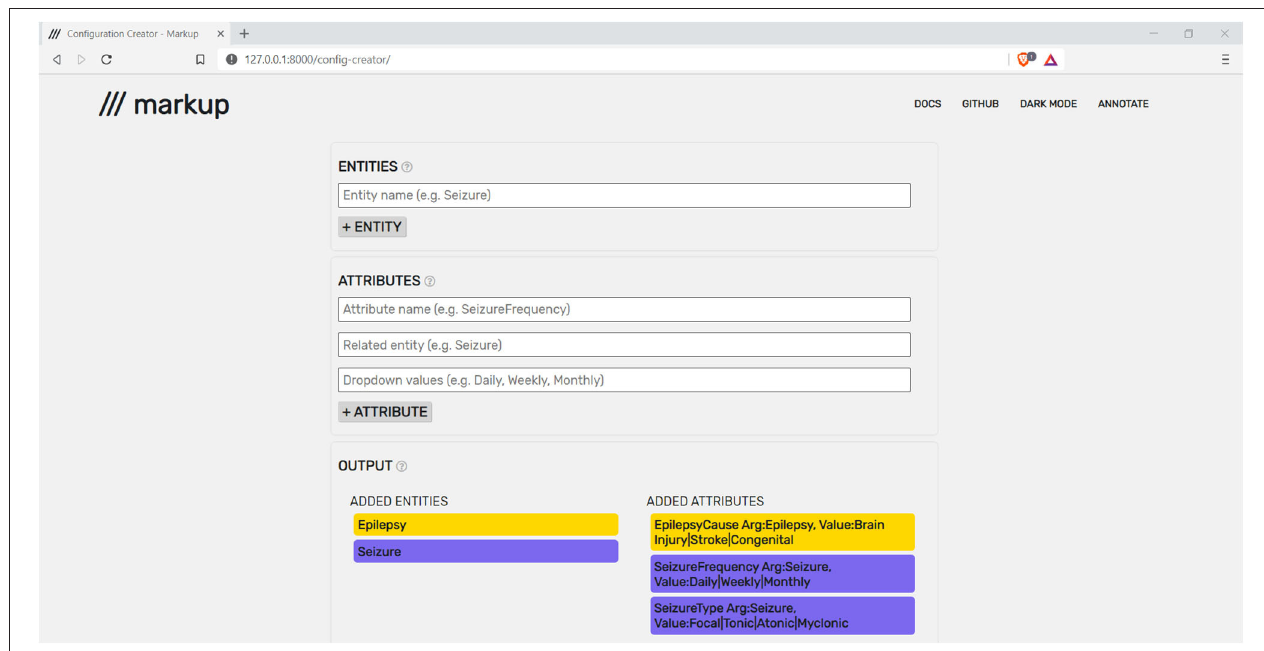
FIGURE 3 | Markup’s built-in configuration file creator being used to construct a file with epilepsy and seizure entities and